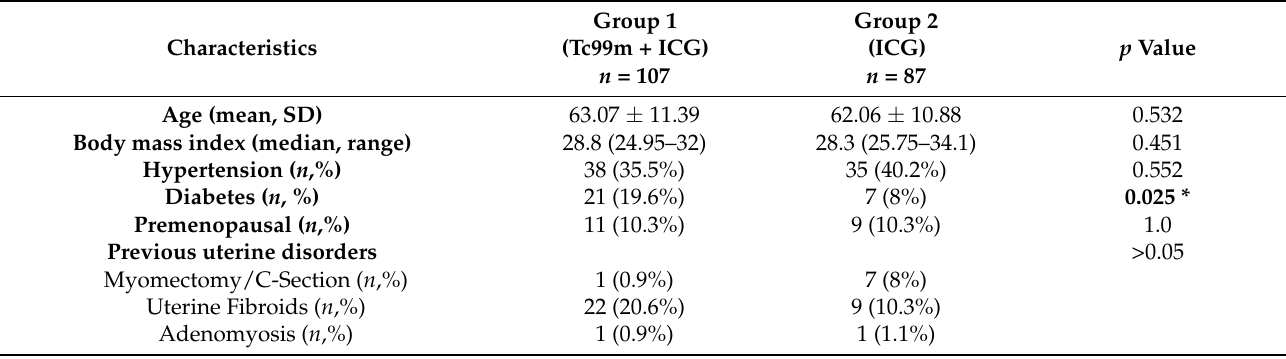
Table 1. Demographic and clinical data of both groups ( n = total number of patients; SD =